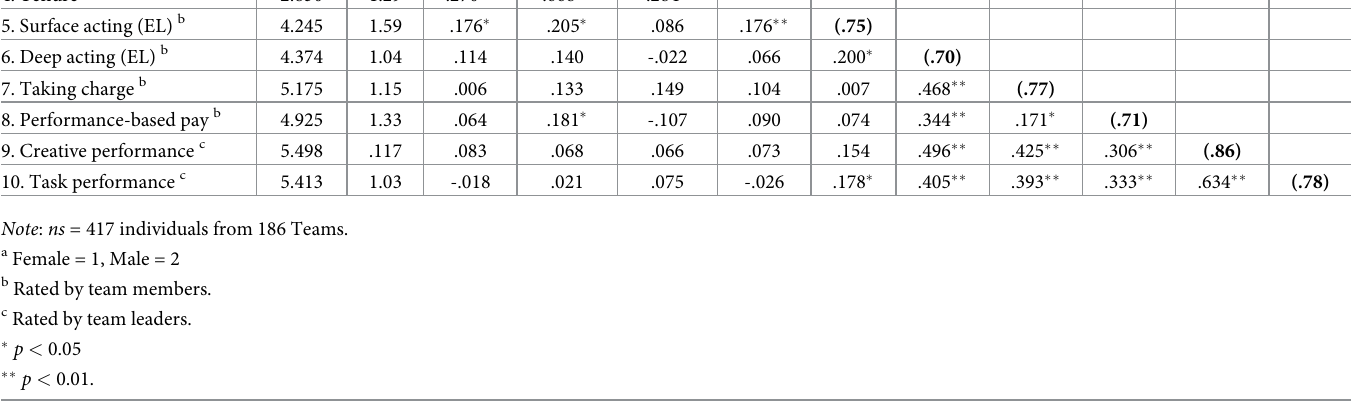
Table 4. Means, standard deviations and correlations. Variables